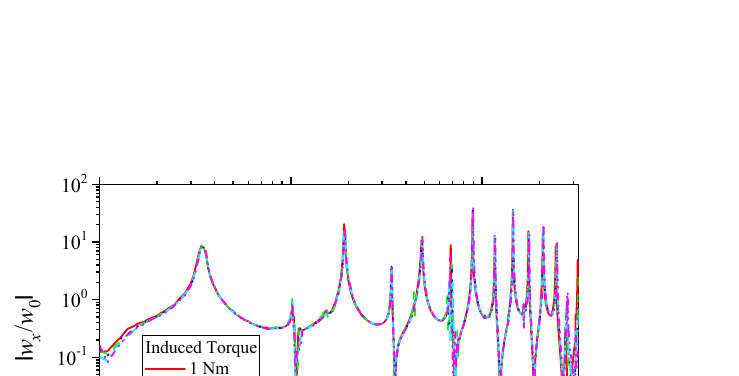
Figure 8. ( a ) Schematic of experimental setup ( b ) and its picture to investigate vibration transmission reduction performance of the fastener specimen. ( c ) Pictures of the probabilistic fastener and bolts connecting the beams.